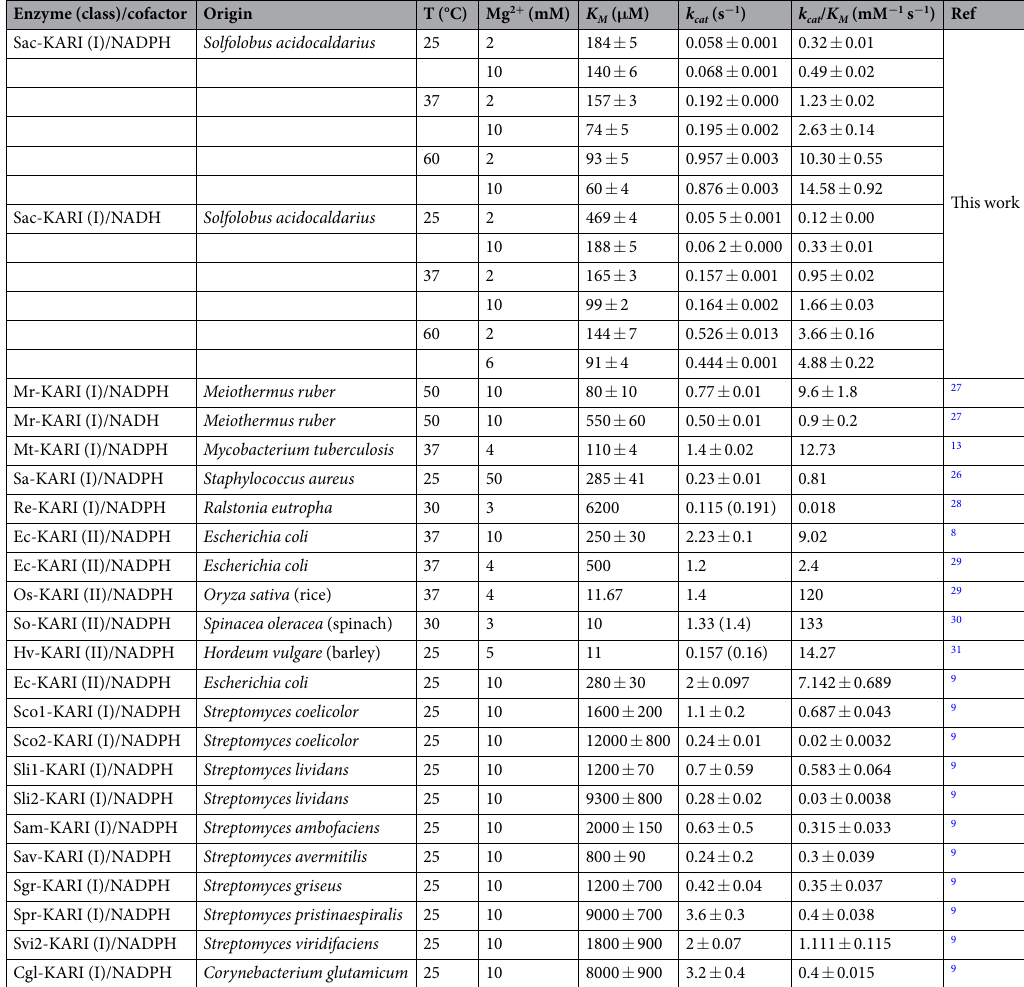
Table 2. Kinetic parameters for the activity of KARI variants towards 2( S )-acetolactate in the presence of saturating concentrations of NADH or NADPH. The value in parentheses is the original value shown in literature and has the units μ mol min − 1 mg − 1 . In this work, enzyme activities were determined in 100